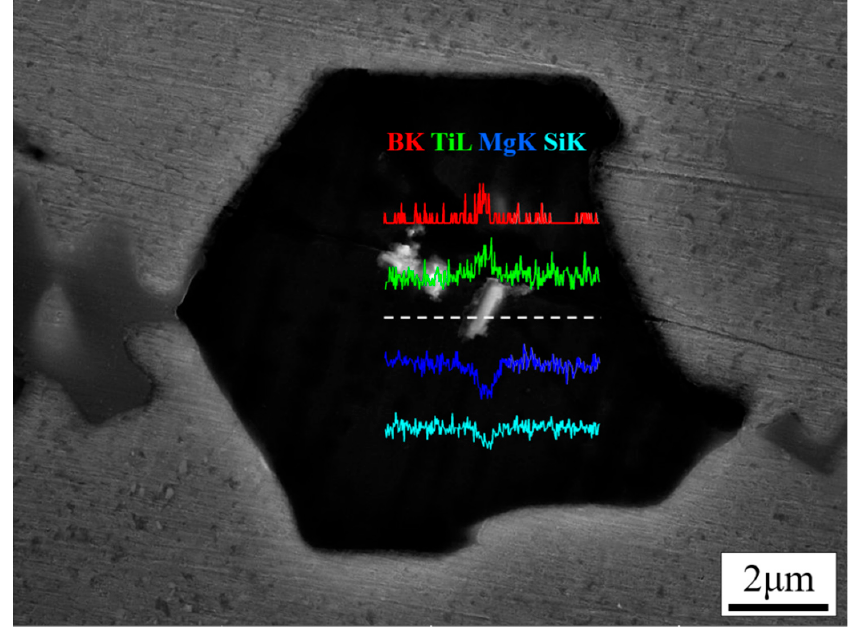
Figure 7. Line scanning analysis image of modified Mg 2 Si phase of Al-8Zn-6Si-4Mg-2Cu-1Ti. TiB 2 particles in Al-5Ti-1B master alloys are shown in Figure 8. Al-5Ti-1B master alloy is known to contain Al 3 Ti and TiB 2 particles, and the TiB 2 particles are agglomerated (Figure 8b). When the amount of Al-5Ti-1B alloy was increased, TiB 2 particles in the master alloy also increased and can act as nucleation site for most eutectic Mg 2 Si.